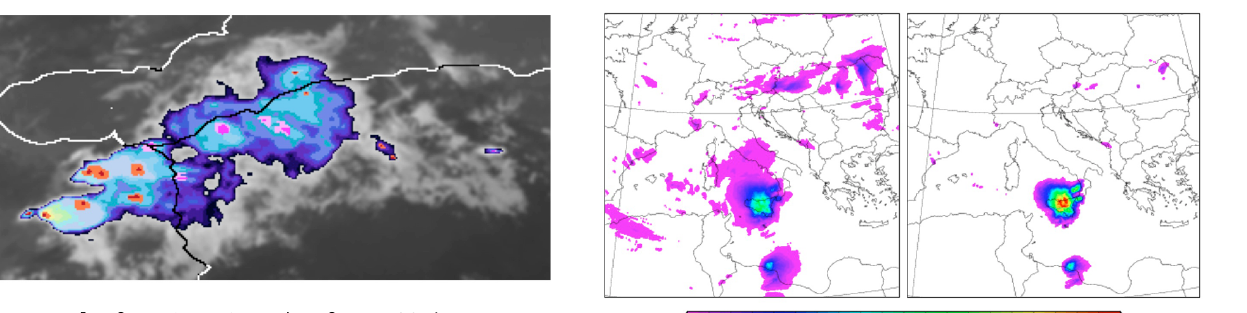
Fig. 6. Example of NEFODINA product from MSG imagery over northwestern Algeria and northeastern Morocco on 29 May 2011 at 17:00UTC. Blue shades are used to show the cloud system of interest. Dark blue shades are used for low clouds, whereas light blue/yellow shades are used for high clouds. Red shades indicate cloud tops of convective cells in development phase. Pink shades indicate cloud tops of convective cells in dissipation phase. The darkest red and pink shades indicate the most intense convective regions.